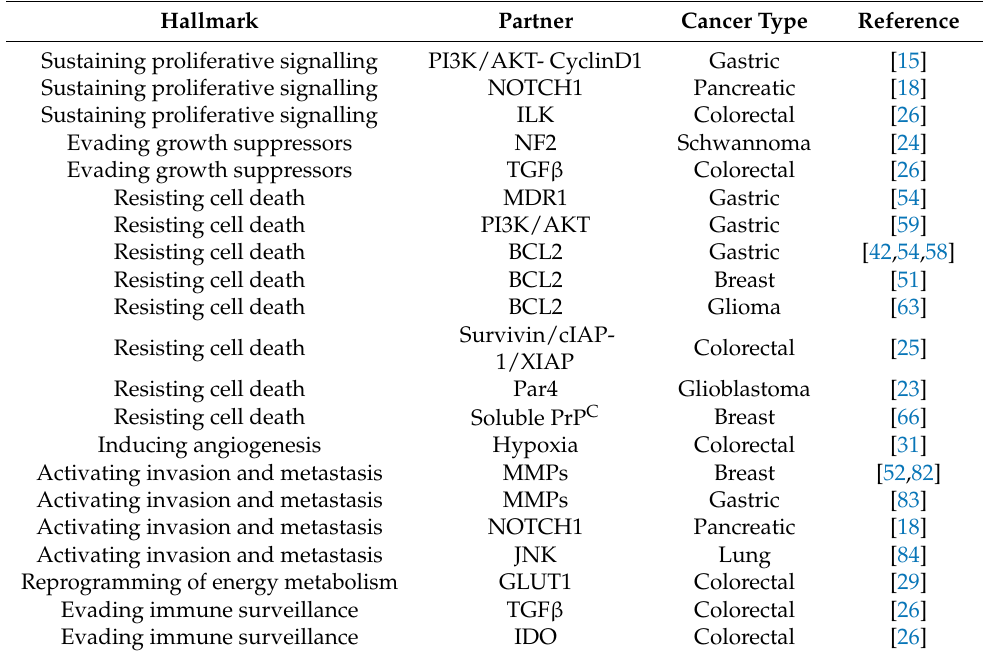
Table 2. Summary of the signalling pathways through which PrP C contributes to a given hallmark of cancer, in relation with the cancer